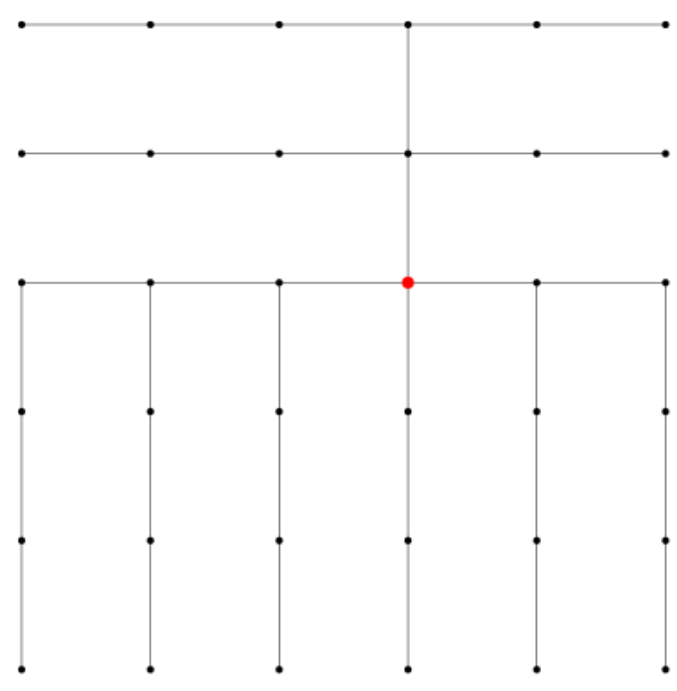
Figure 4. Shortest path tree from red